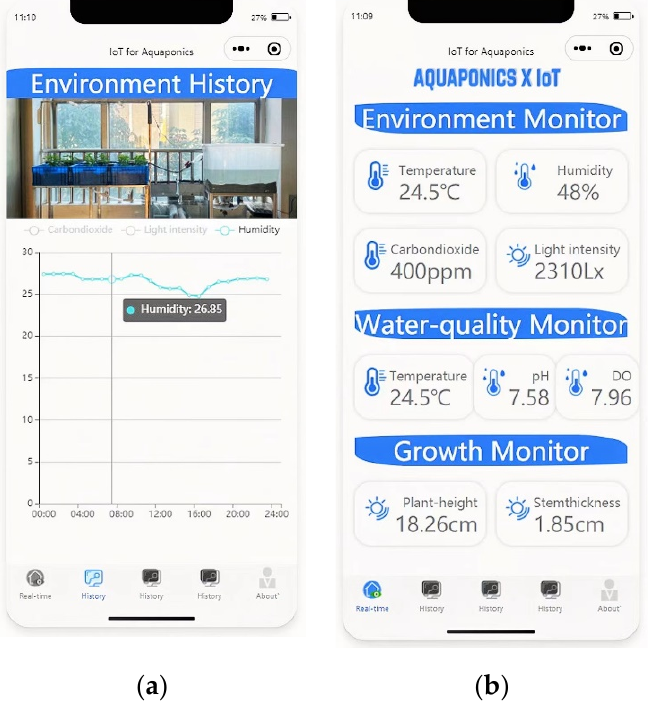
Figure 12. Pages of Mini Program for monitoring aquaponics system. ( a ) The curves of 3 environment indicators in 24 h; ( b ) Page of real-time system monitoring.